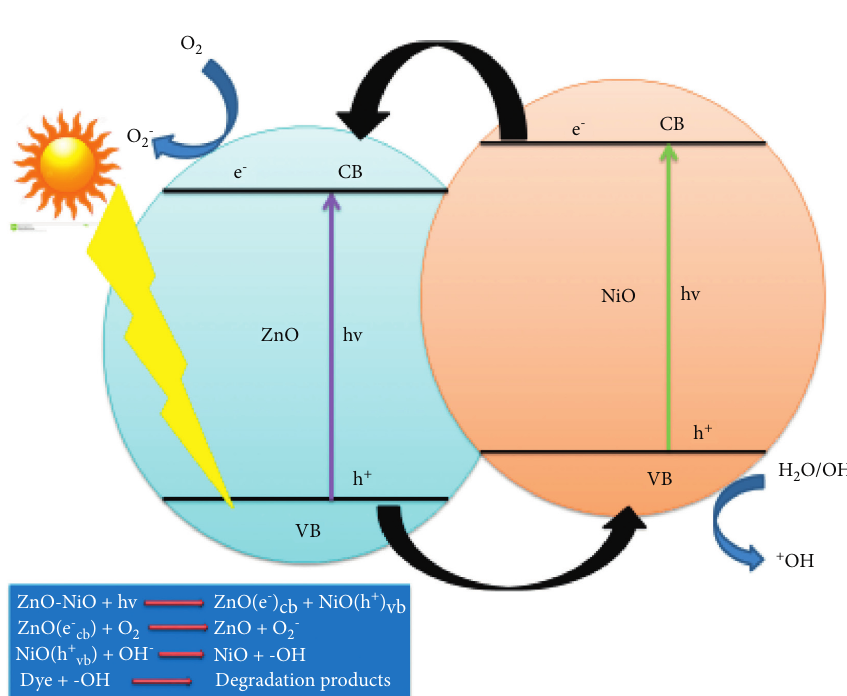
Figure 10: Schematic representation of electron flow during